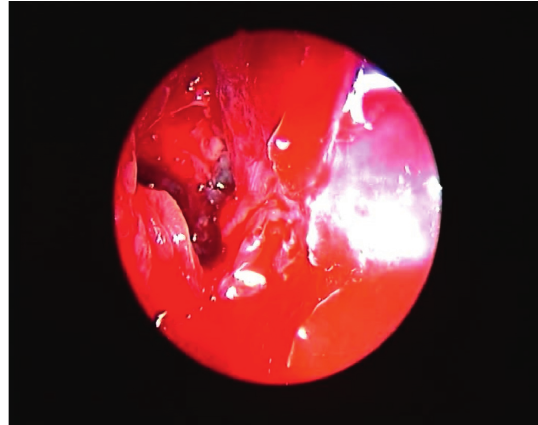
Figure 9: Endonasal endoscopic localization of the CSF leak in the posterior wall of the frontal